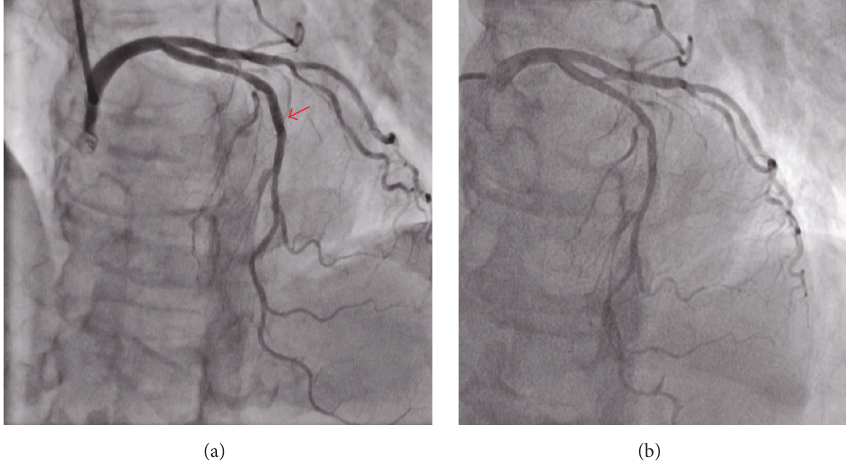
Figure 4: (a) Final coronary angiogram after stenting (red arrow). (b) Diagnostic coronary angiogram after 2 years of stenting.